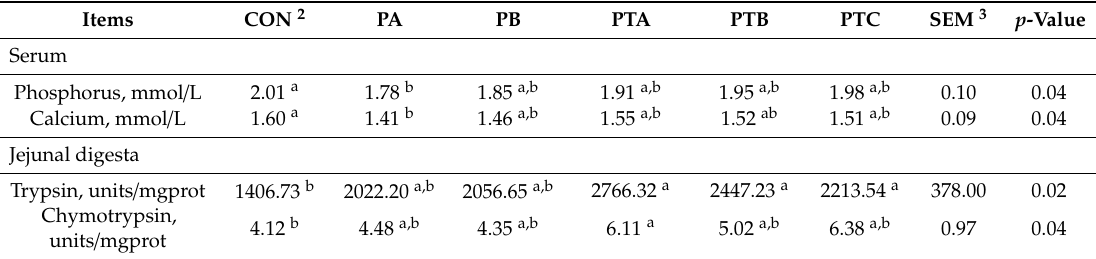
Table 4. E ff ects of di ff erent protease or phytase on serum physiochemical parameters and digestive enzyme activities in ducks 1